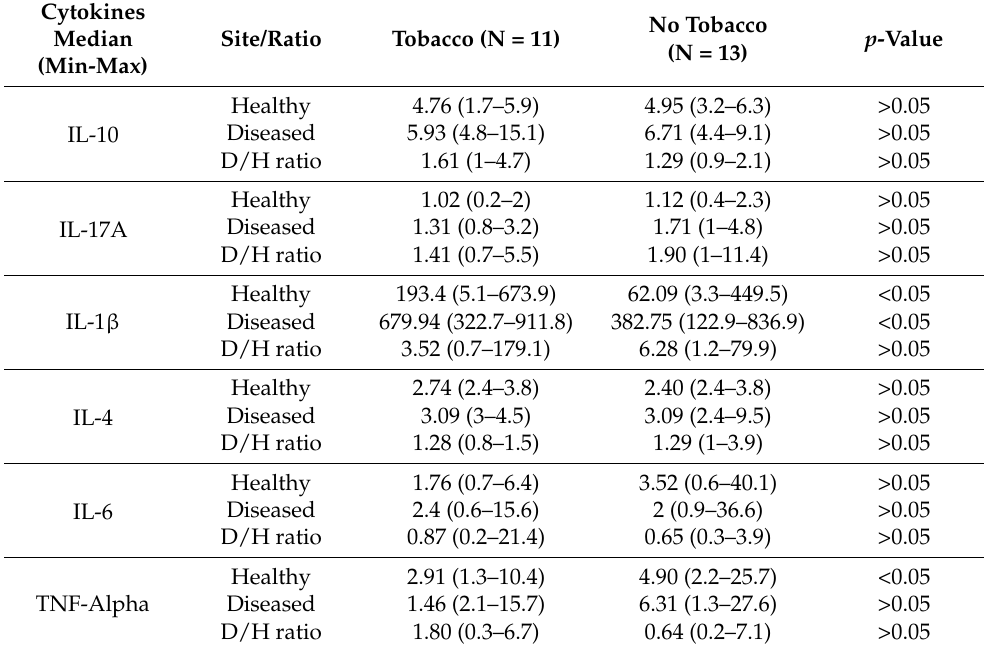
Table 2. Comparison between GCF cytokines and the smoking